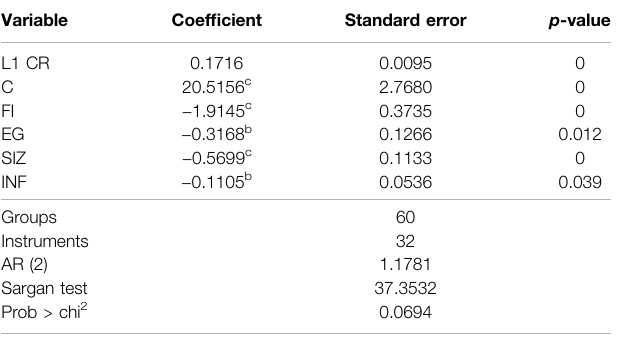
TABLE 6 | Generalized method of movements (2-Step System GMM) regression results. Variable